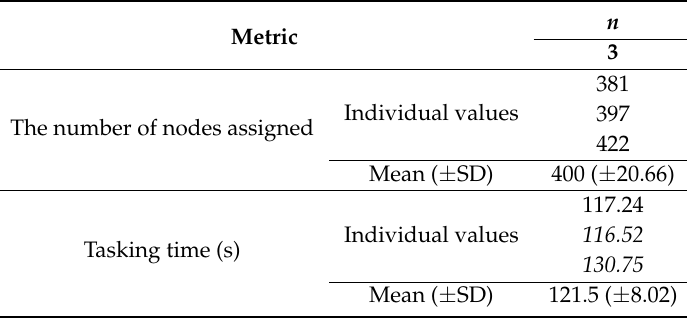
Table 4. Results of the